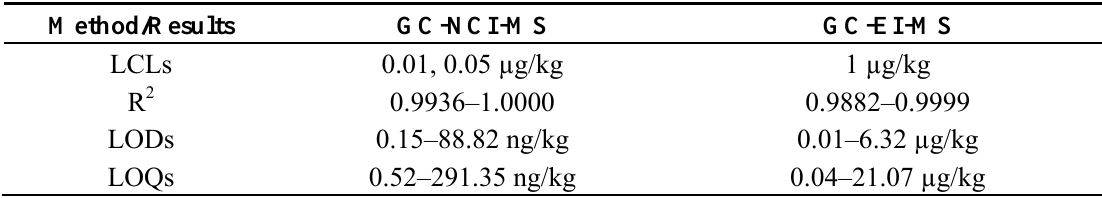
Table 5. Comparison of validation parameters for NCI vs . EI mode of fast GC-MS analysis of EDPs residues in apple matrix